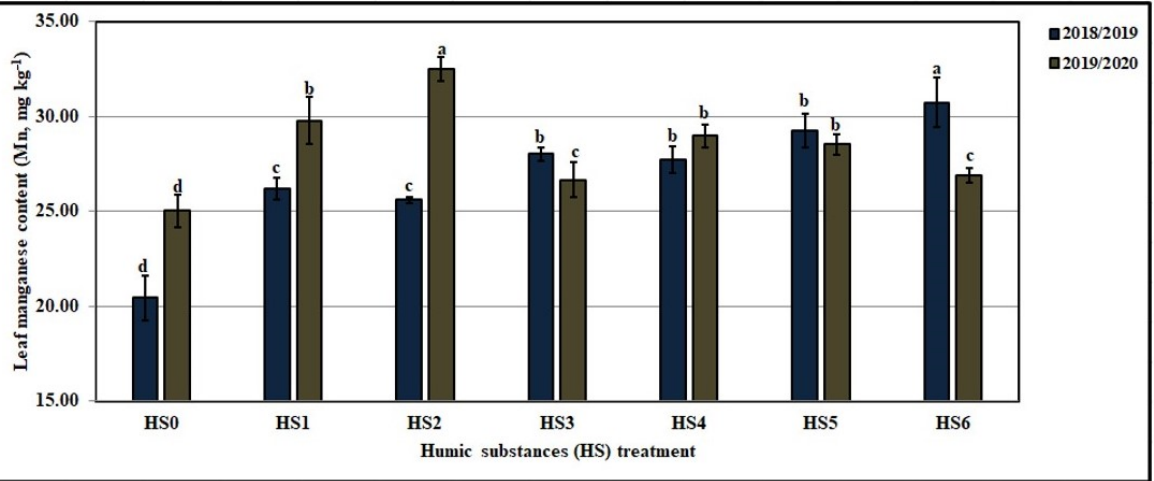
Figure 26. Influence of humic substances treatments on leaf manganese contents (Mn, mg kg − 1 ) of some wheat varieties grown in clay loam soil in 2018/2019 and 2019/2020 seasons. Bars in the same years with a different letter indicate significant differences between treatments at p ≤ 0.01. HS 1, HS 2 , HS 3 represent HS applied as foliar spray at 1.0, 2.0, 4.0 g L − 1 , respectively, HS 4 , HS 5 , HS 6 represent HS applied as soil application at 5.04, 7.56, 10.08 kg ha − 1 .